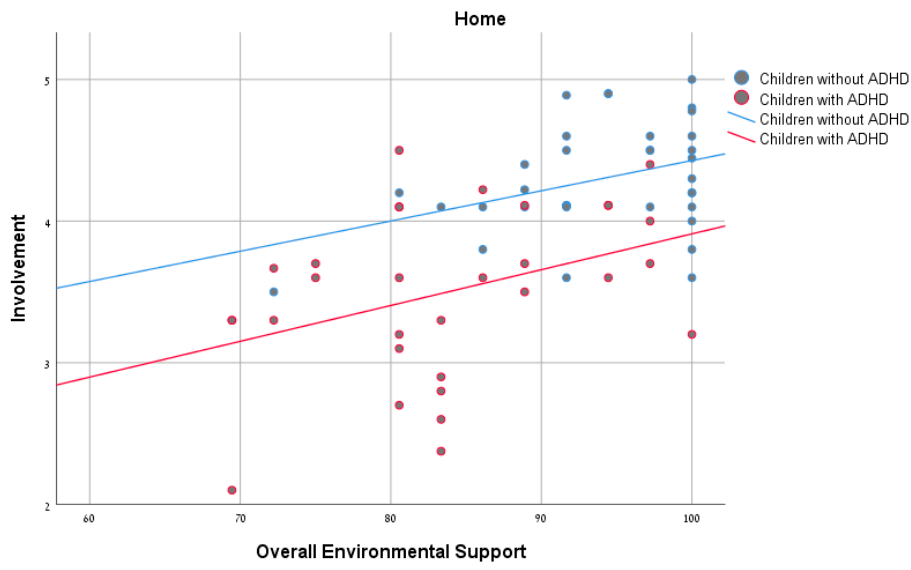
Figure 1. Correlations between overall environmental support and involvement among children with and without attention deficit hyperactivity disorder (ADHD) in the home environment.